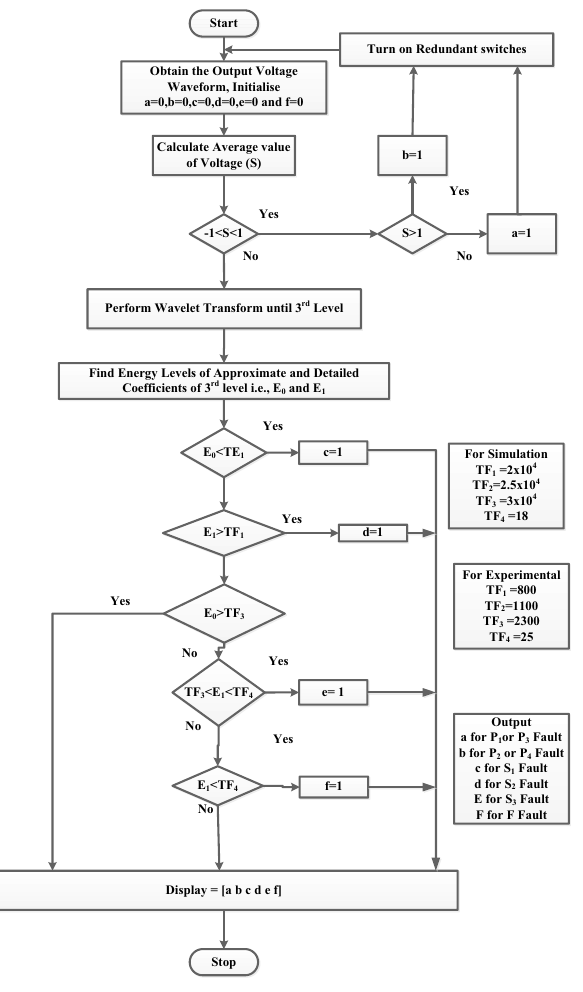
Fig. 12 Flowchart for detection of open circuit fault in switches